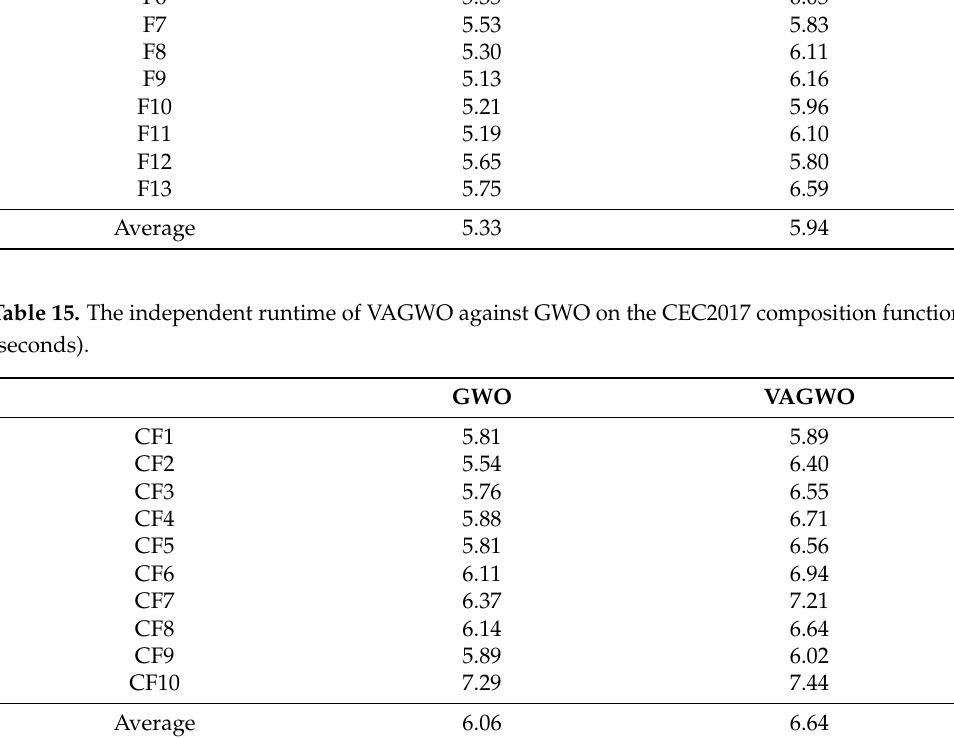
Table 14. The independent runtime of VAGWO against GWO on the standard functions (seconds). GWO